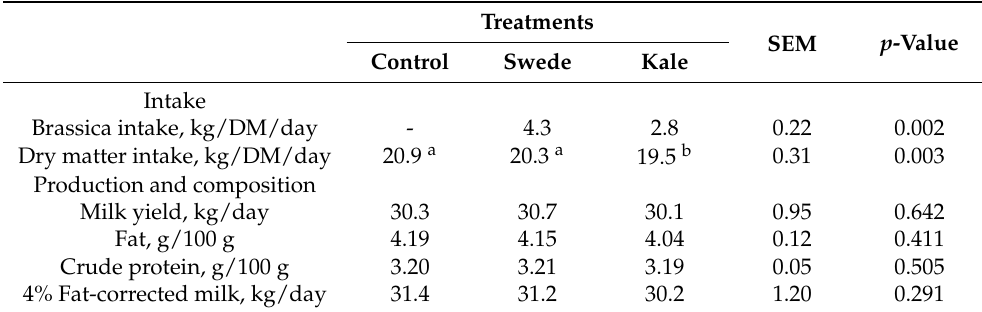
Table 2. Dry matter intake, milk production and milk composition by early lactating dairy cows fed a control diet or with kales or